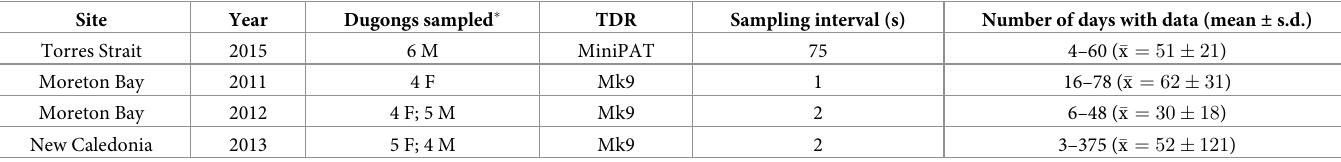
Means and standard errors (SE) of the maximum depths at which Dugong Secchi Disks were visible to experienced aerial observers under the Environmental Conditions Index (ECI), plus the depths of the detection zones used to estimate the proportion of time dugongs were available to aerial observers. 1 The experiment was not repeated for ECI1 because by definition all dugong models were available for detection by trained observers in aircraft at 500 ft (~152.4 m) under such environmental